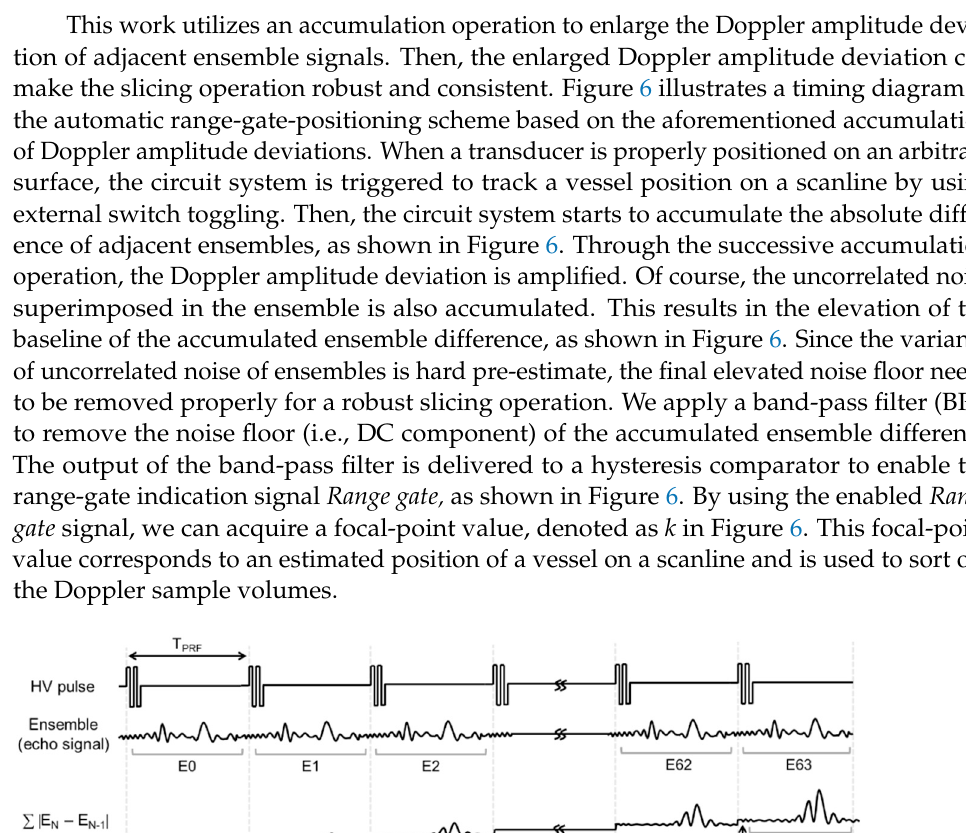
Figure 7. Block diagram of range-gate-positioning scheme in FPGA; ADC: analog-to-digital con- verter; BPF: band-pass filter; FIFO: first-in first-out. The output of BPF1 is selectively fed into one of the FIFO memories in a ping-pong fashion. To compute the absolute difference between two single-port FIFO memories, an adder and an absolute-value operator follow. This computation can result in the Doppler amplitude deviation between adjacent ensemble signals. The amplification of Doppler amplitude deviation is executed with a dual-port FIFO memory and an accumulator. After a pre-determined number of accumulation operations, the dual-port FIFO memory deliv- ers its code into the filter BPF2 . As shown in Figure 6, the baseline of accumulated code also increases due to the accumulation of uncorrelated noise. The filter BPF2 removes the DC component, and the alternating signal component among the filter output provides the information to estimate a focal-point number for the vessel region. Since the filter BPF2 removes the DC component, the alternating signal of the filter output has a zero-crossing feature. Therefore, we need to generate a short-period one- pulse signal (i.e., Range gate in Figure 7) at a time duration where an alternating-signal packet with sufficient amplitude occurs. To generate a properly toggled Range gate signal, we adopt a hysteresis operation on a digital comparator. A timing diagram and concep- tual operation of the hysteresis comparator are shown in Figure 8. When an alternating- signal packet with sufficient amplitude occurs at the output of BPF2 , it is detected by a slicing operation with a hyper-parameter threshold value D TH . That is, when the output